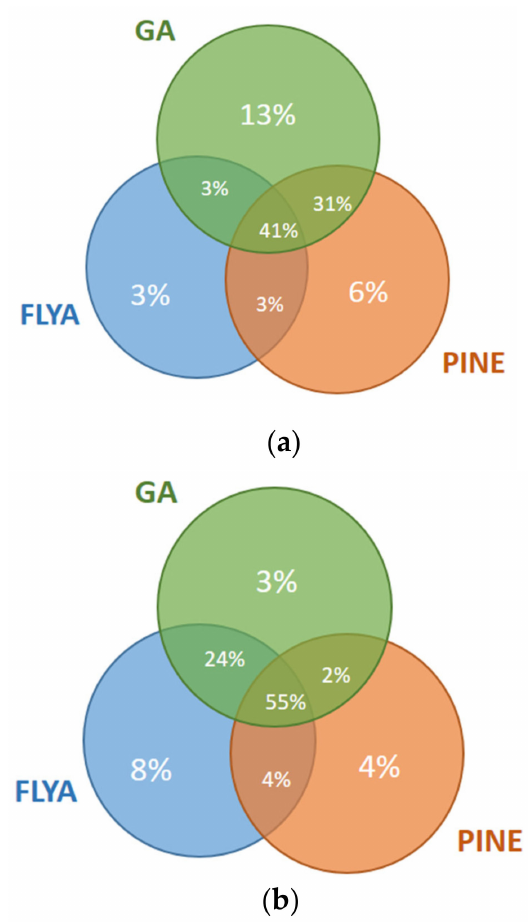
Figure 8. Mutual agreement of correct assignments among different algorithms for the ( a ) 1st fragment and ( b ) 4th fragment of Fes SH2. The percentages of the correct assignments are given relative to the total number of correctly assigned atoms in the corresponding fragment of the Fes SH2